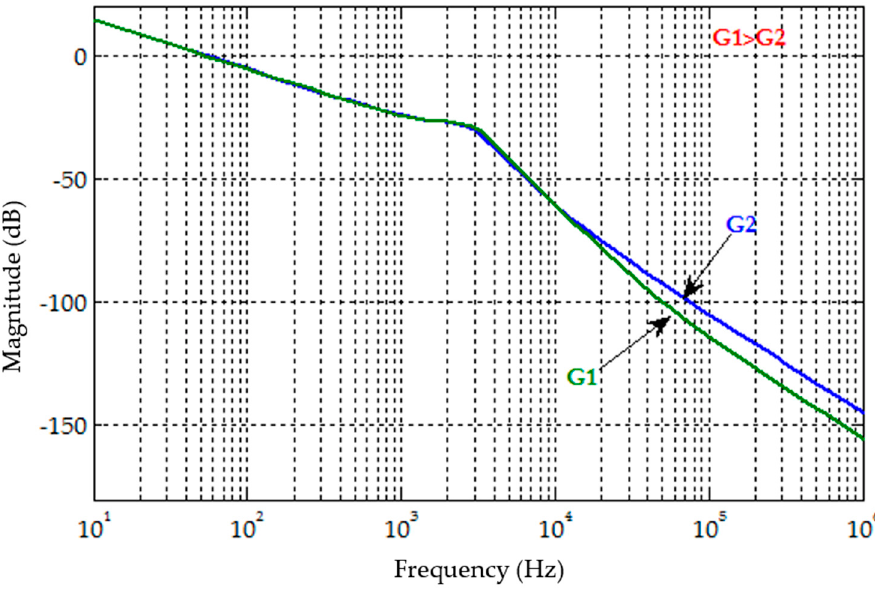
Figure 11. Frequency response characteristics for varying resistance ratio with R r constant.